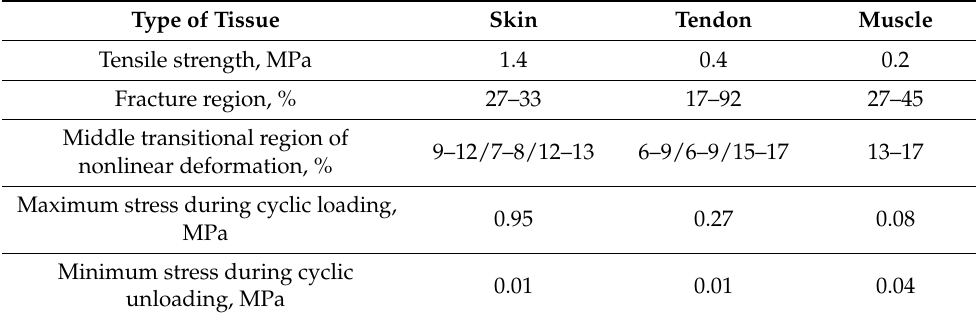
Figure 8. Engineering tensile stress-strain curves of the muscle in the 5 loading-unloading cycles and the uniaxial tension to rupture (inset). Table 1. Mechanical properties of different